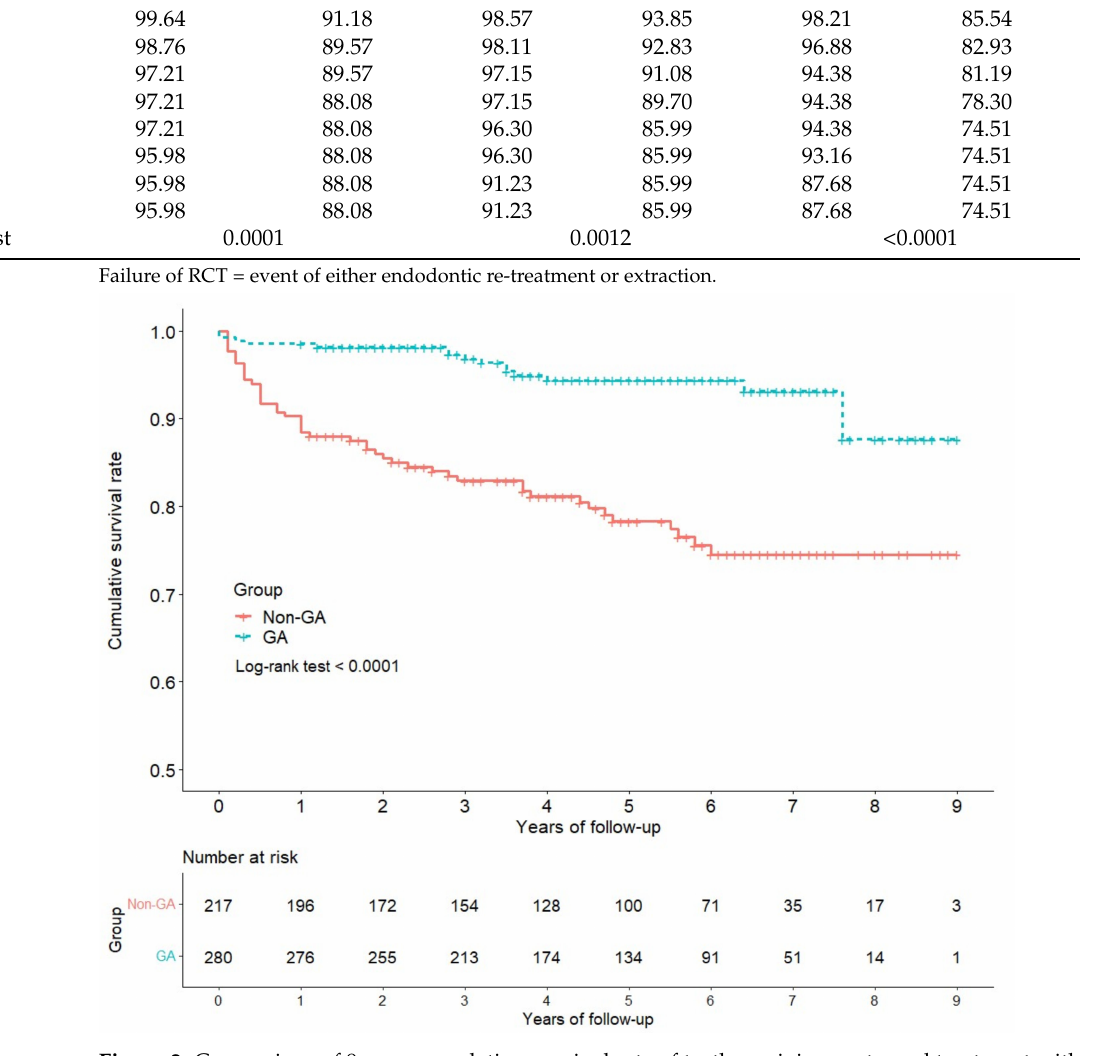
Figure 2. Comparison of 9-year cumulative survival rate of teeth receiving root canal treatment with and without general anesthesia. GA, general anesthesia; non-GA, not general